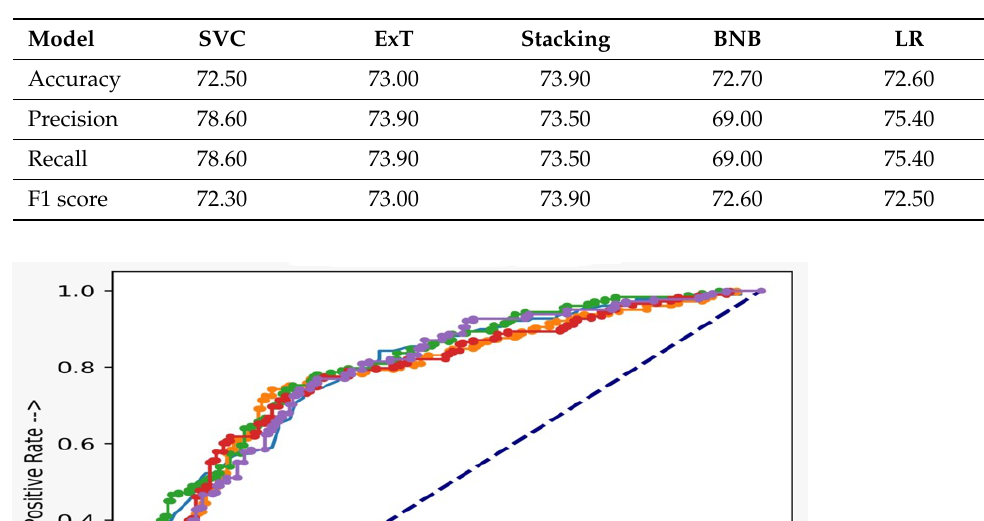
Figure 6. ROC-AUC using 5-fold cross-validation. Table 12. Results of 10-fold cross-validation.